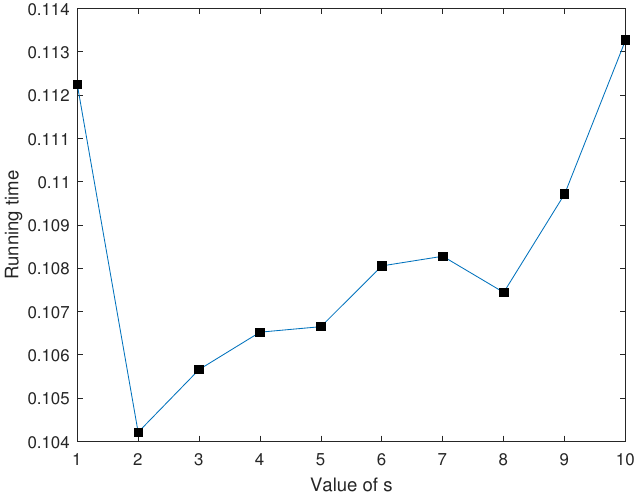
Figure 5. Running time with noiseless data after 100